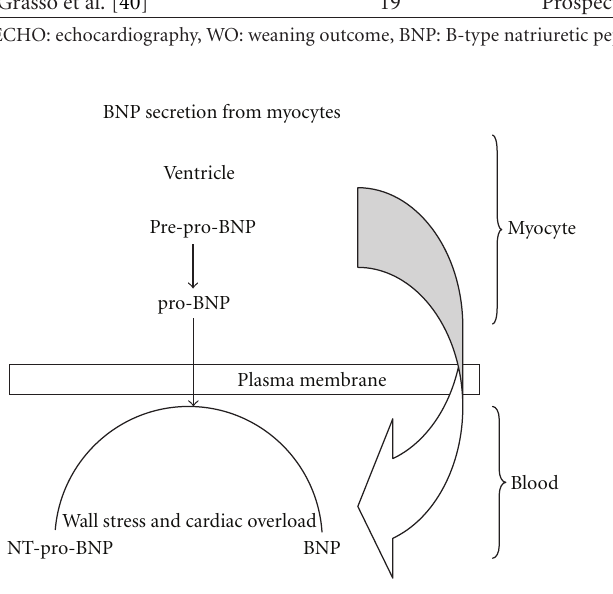
Figure 3: BNP: B-type natriuretic peptide, NT-pro-BNPL: N- terminal pro-B-type natriuretic